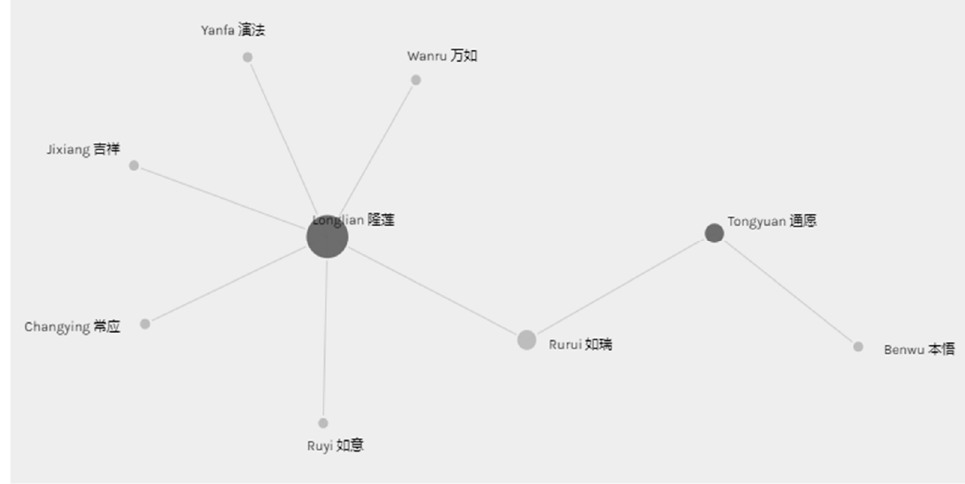
Figure 4. Longlian and Tongyuan’s educational networks 27 (source: